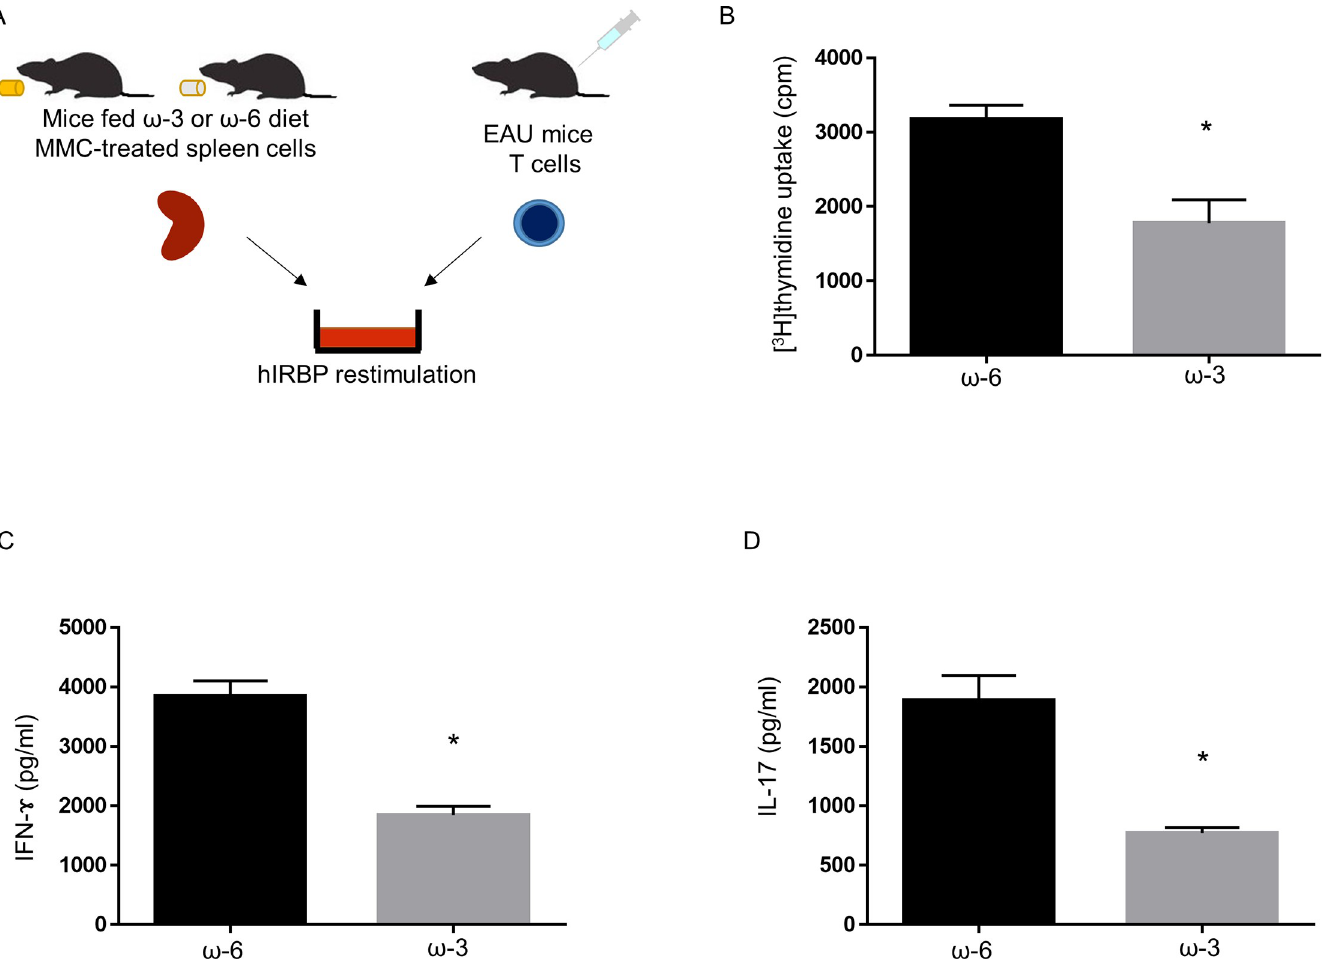
Fig 1. T cell proliferation as well as IFN- γ and IL-17 production in cocultures of CD4 + T cells from EAU mice and APCs from mice fed ω -3 or ω -6 LCPUFAs. (A) Experimental scheme. Mitomycin C (MMC)–treated spleen cells (3 × 10 5 ) isolated and separately pooled from mice fed a diet supplemented with ω -3 ( n = 5) or ω -6 ( n = 5) LCPUFAs for 14 days were cultured for 48 h in the presence of hIRBP(1–20) (10 μ g/ml) and with CD4 + T cells (3 × 10 5 ) isolated and pooled from lymph nodes of EAU mice ( n = 5) at 17 days after injection of hIRBP(1–20). (B) The proliferation of the T cells was then assessed by measurement of [ 3 H]thymidine incorporation. Data are means + SEM from three independent experiments. (C, D) The concentrations of IFN- γ (C) and IL-17 (D) in the coculture supernatants were measured with ELISAs. Data are means + SEM from three independent experiments. � P < 0.05 versus ω -6 LCPUFA diet (Mann-Whitney U